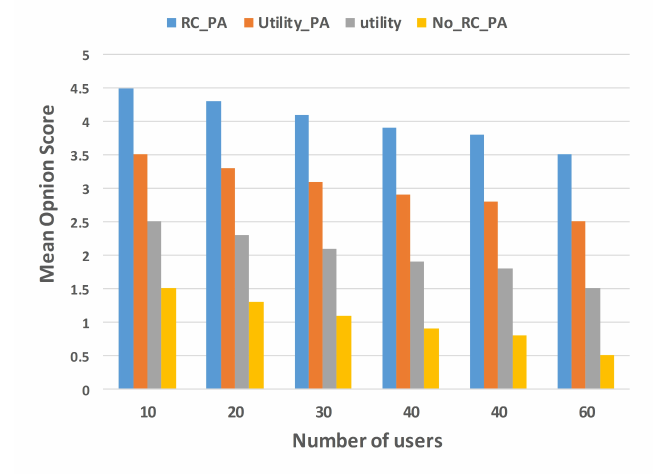
Figure 7. MOS vs. number of